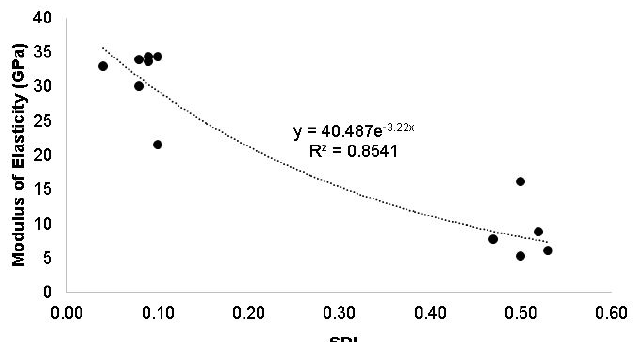
Figure 19. Correlation between Stiffness Damage Index (SDI) and modulus of